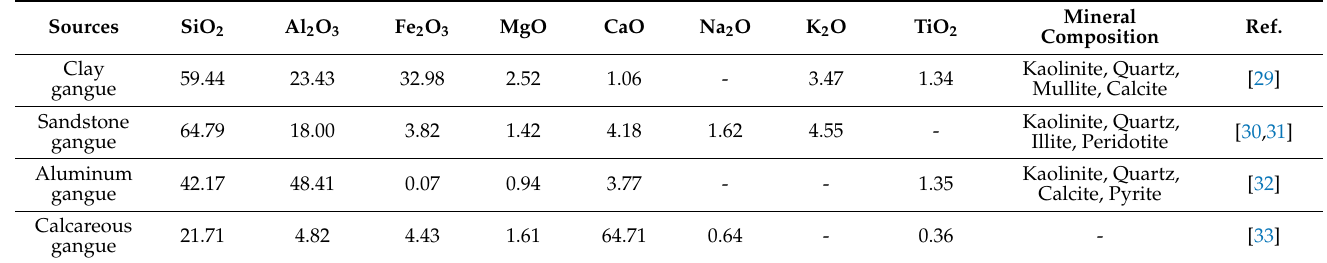
Table 2. Chemical composition and mineral composition of different types of coal gangue.